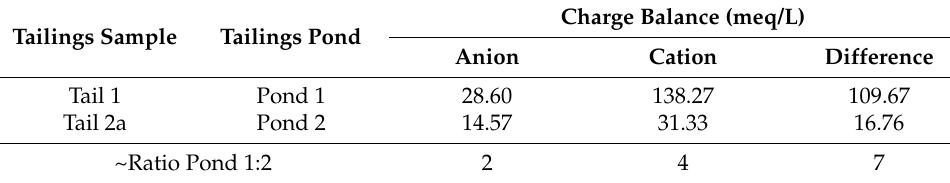
Table 5. Charge balance for the Stillwater tailings storage facilities.